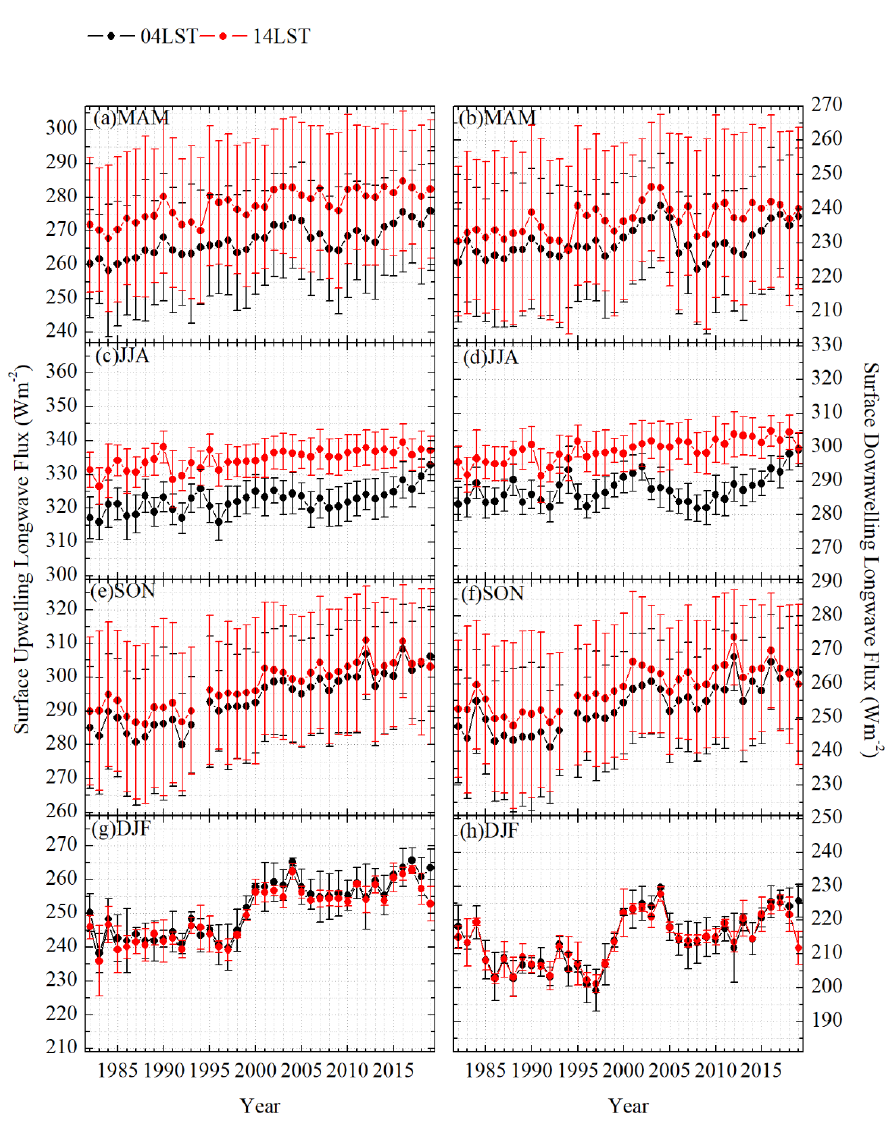
Figure 4. Time series of seasonal ULF ( a , c , e , g ) and DLF ( b , d , f , h ) over the seas in Arctic (60°~90°N) from 1982 to 2019 at 04:00 LST and 14:00 LST. ( a , b ) MAM, ( c , d ) JJA, ( e , f ) SON, and ( g , h ) DJF. Bars represent ± standard deviation of the mean in each year.